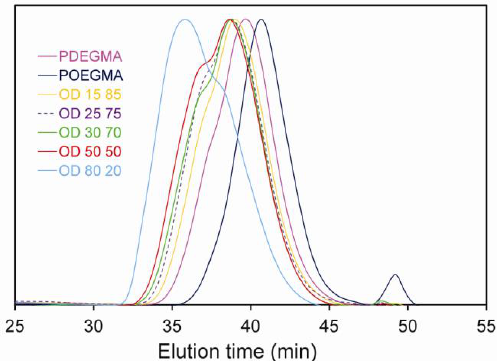
Figure 5. Chromatograms of the polymers and copolymers of DEGMA and OEGMA obtained by RAFT polymerization.